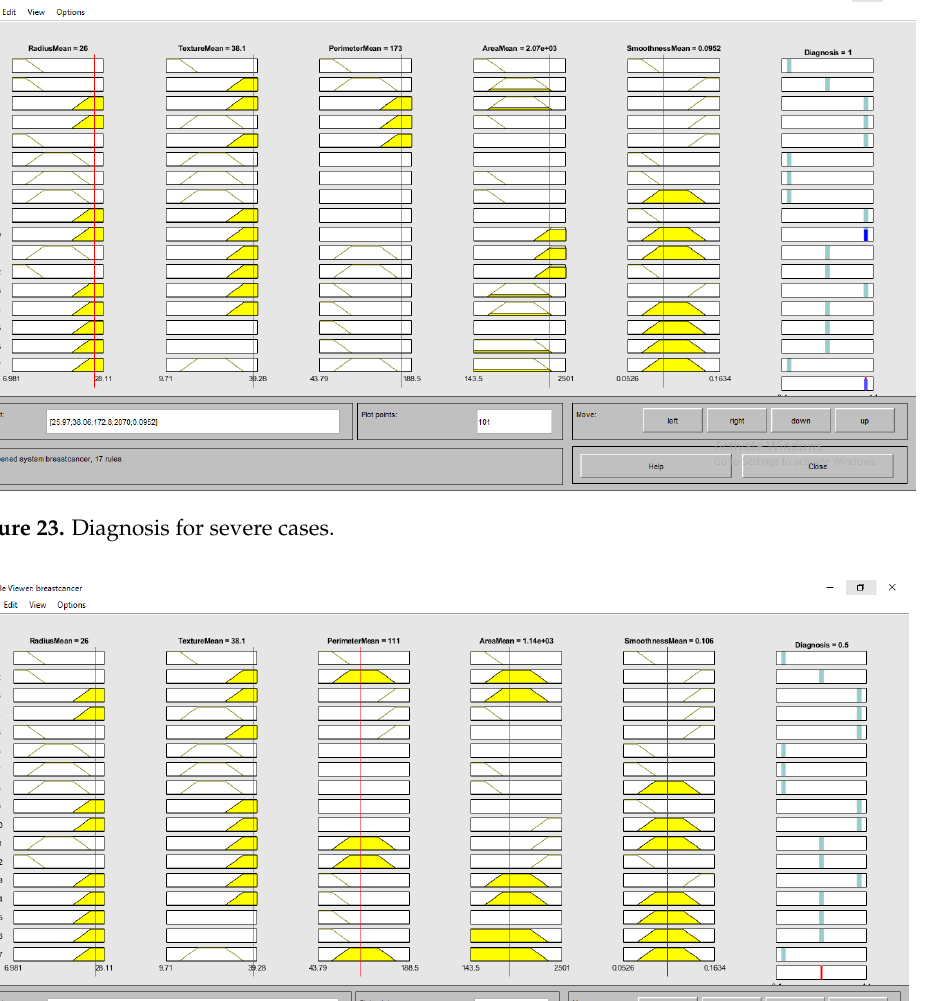
. Figure 25. Diagnosis for healthy cases. Table 6 shows the results of system diagnosis of breast cancer based on the healthy, mild, and severe cases, which were 300 randomly selected instances from the wisconsin diagnostic breast cancer dataset. Table 6. Results of system for diagnosis of breast cancer Class